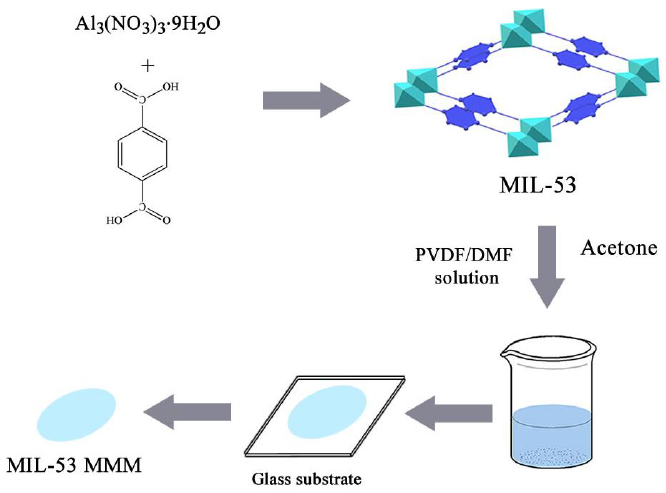
Figure 2. Illustration for the synthesis of the MIL-53 MMM.